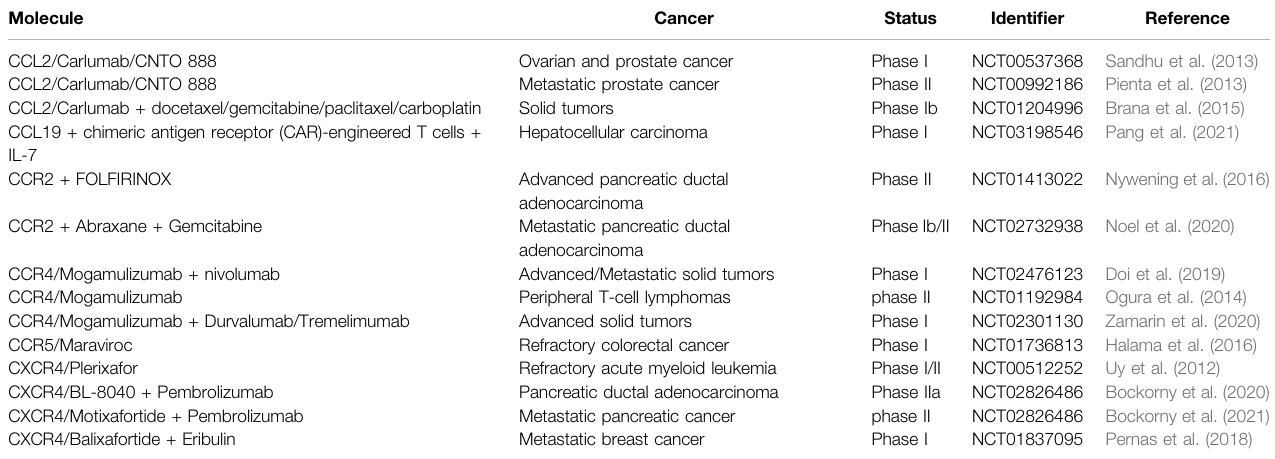
TABLE 3 | Clinical trials involving chemokine therapy for cancer.